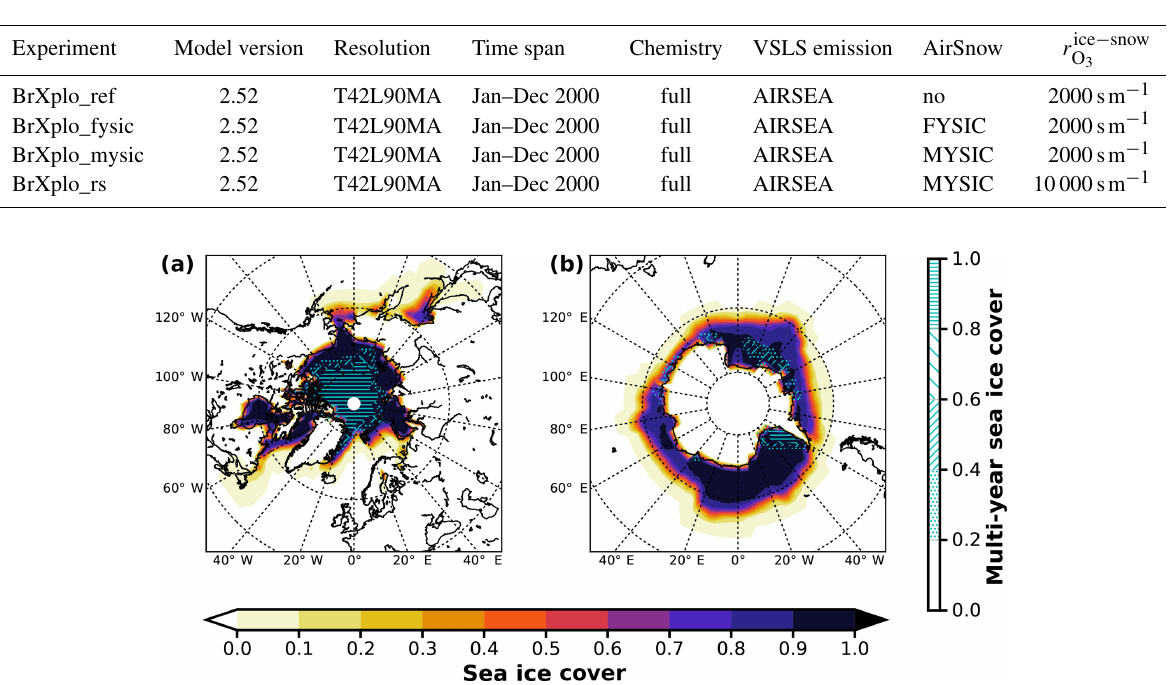
Figure 2. Sea ice cover fraction and estimated multi-year sea ice cover fraction for the year 2000. Mean SIC is shown for April in the Northern Hemisphere and September in the Southern Hemisphere. MYSIC has been computed from RC1SD-base-08 10-hourly SIC based on ERA-Interim. For simplicity, we assume ice that survived one melting season at a fixed location as multi-year. (a) Northern Hemisphere; (b) Southern